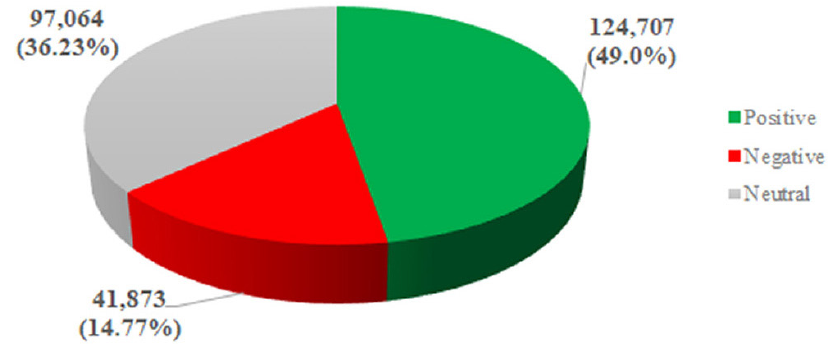
Fig. 7. Polarity frequency of the educational tweets over the years 2010–2020 using